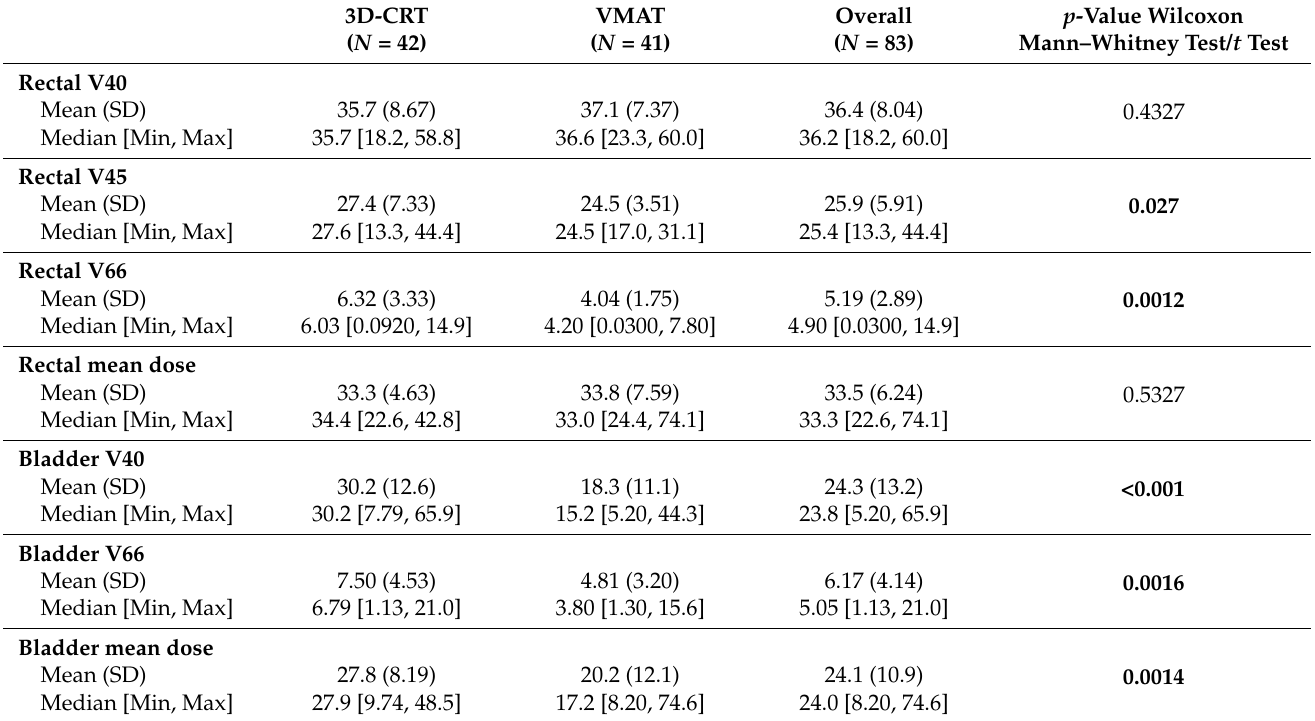
Table 4. Outlines of rectal and bladder dosimetric volume histogram (DVH) for radiotherapy technique. 3D-CRT VMAT Overall p -Value Wilcoxon